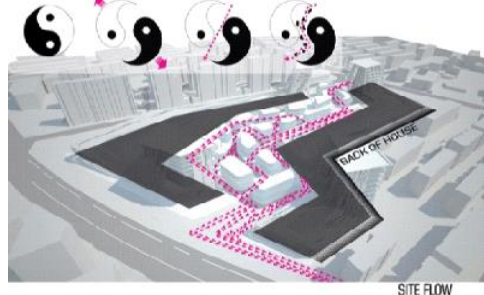
Fig. 14: International Plaza, Shanghai Wuzhou. (BOJOVIC, 2013) Fig.15: Conceptual form. (BOJOVIC,